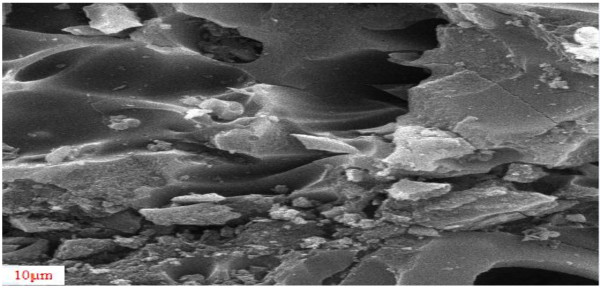
SEM image of modified granular activated carbon.